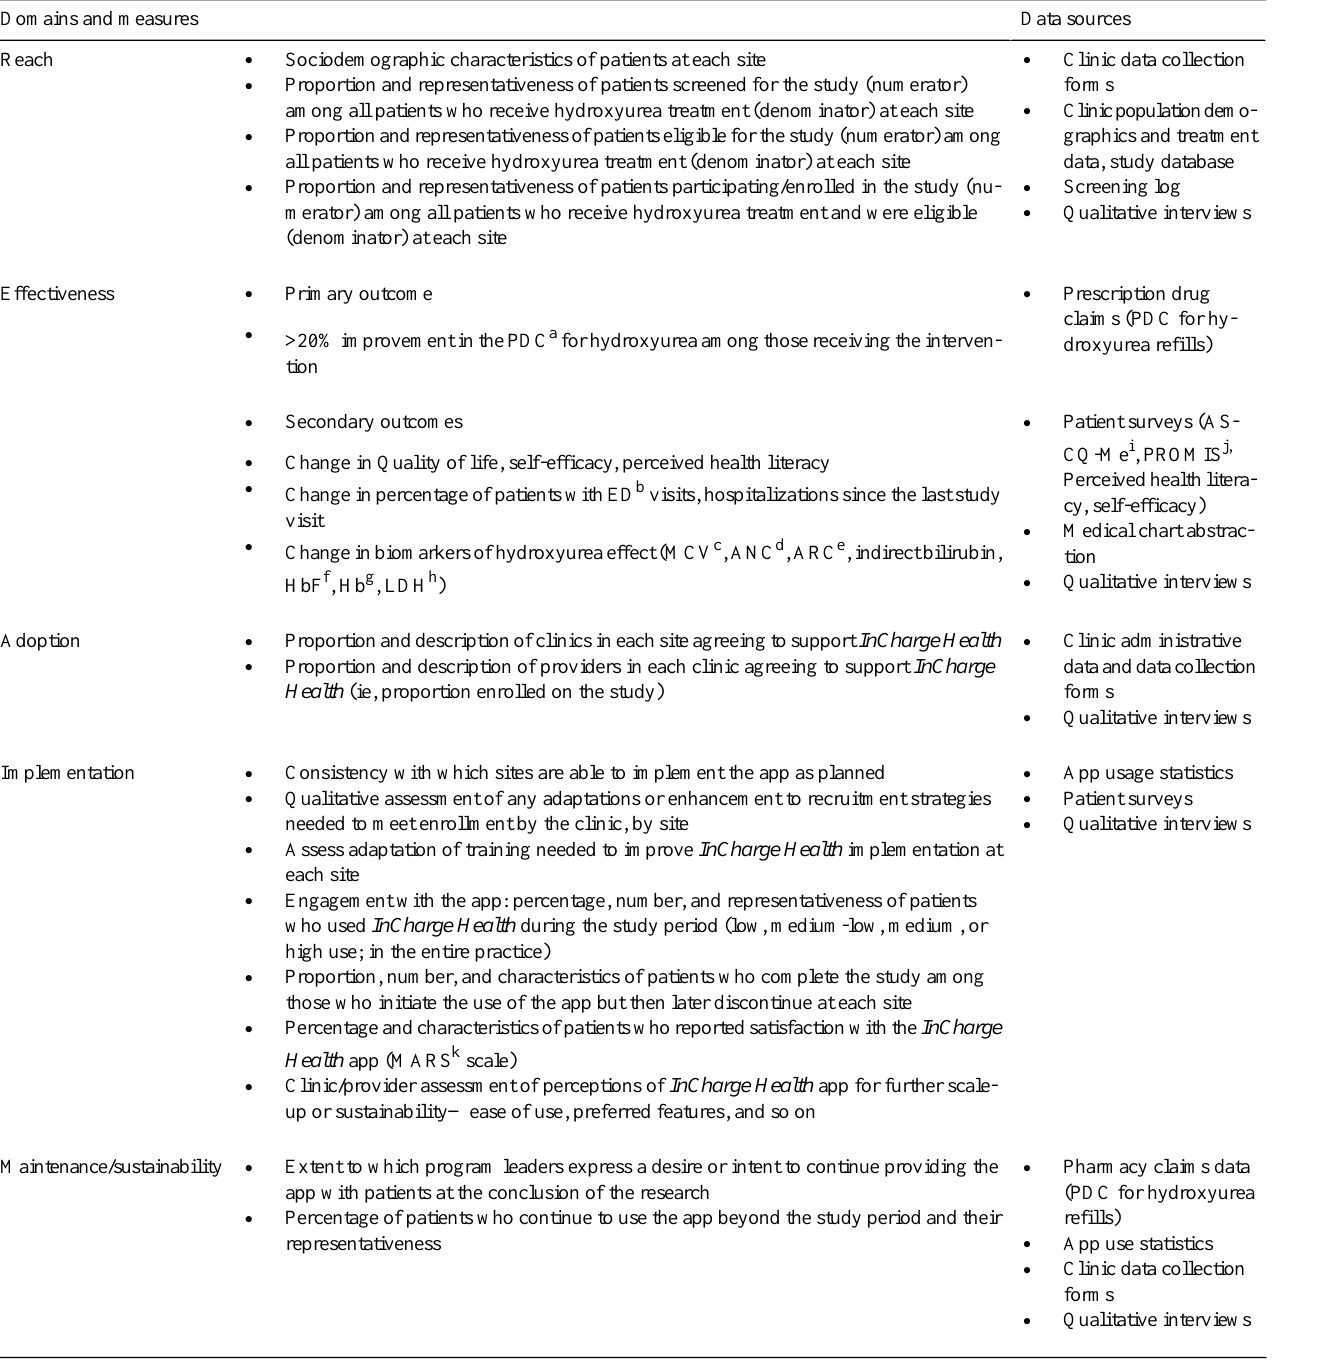
Data sourcesDomains and measures • Screening log • Proportion and representativeness of patients participating/enrolled in the study (nu- •